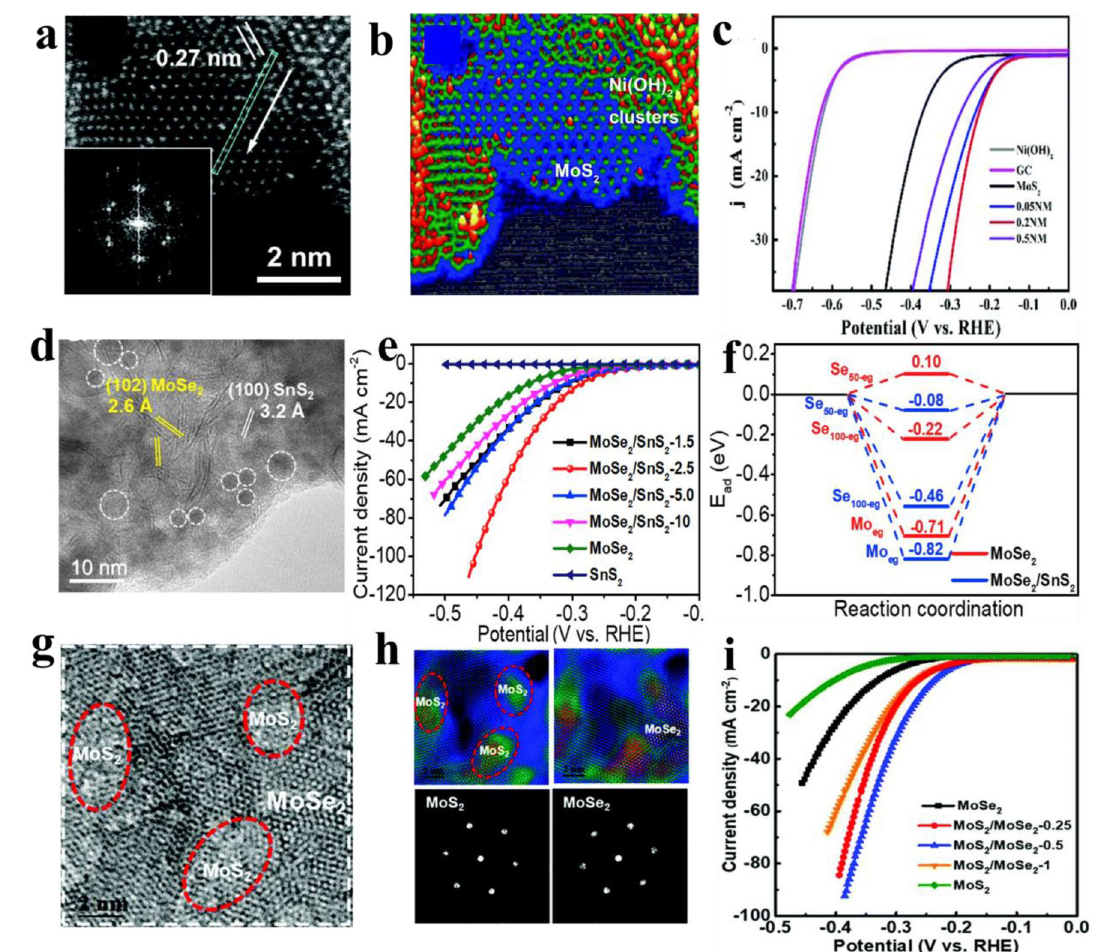
Fig. 3 a HAADF-STEM image of Ni(OH) Water adsorption energy diagram for MoSe 2 /SnS 2 heterostructures 2 /MoS 2 heterostructures. Insets: the corresponding FFT patterns. b The surface plot image of and pure MoSe 2 [50], g HRTEM image of MoS 2 /MoSe 2 heterostruc- ( a ). c LSV curves of the Ni(OH) 2 , MoS 2 , and 0.05NM, 0.2 NM, and ture. h IFFT image from the selected masked FFT patterns (top) and the selected FFT patterns (down) for MoSe 2 and MoS 2 . i LSV curves 0.5 NM (NM: the abbreviation of Ni(OH) 2 /MoS 2 heterostructure) [49], d TEM images of MoSe 2 /SnS 2 -2.5 heterostructure. e Polari- of MoS 2 /MoSe 2 heterostructures, MoS 2 , and MoSe 2 in 1-M KOH zation curves of MoSe 2 /SnS 2 heterostructures, SnS 2 , and MoSe 2 . f solution